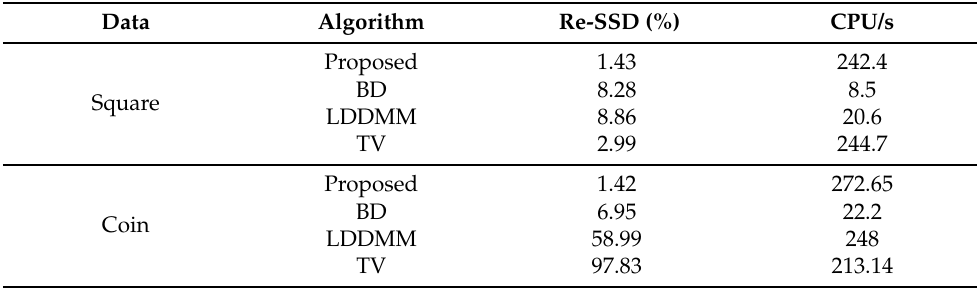
Figure 14. Registration result for different scales on image pairs of Underwater coin. ( a ) T ( · ) . ( b ) Re − SSD = 12.48%. ( c ) Re − SSD = 2.95%. ( d ) Re − SSD = 1.85%. ( e ) Re − SSD = 1.55%. ( f ) Re − SSD = 1.42%. Table 3. Quantitative comparison of registration results of four different algorithms (test for under- water distorted image